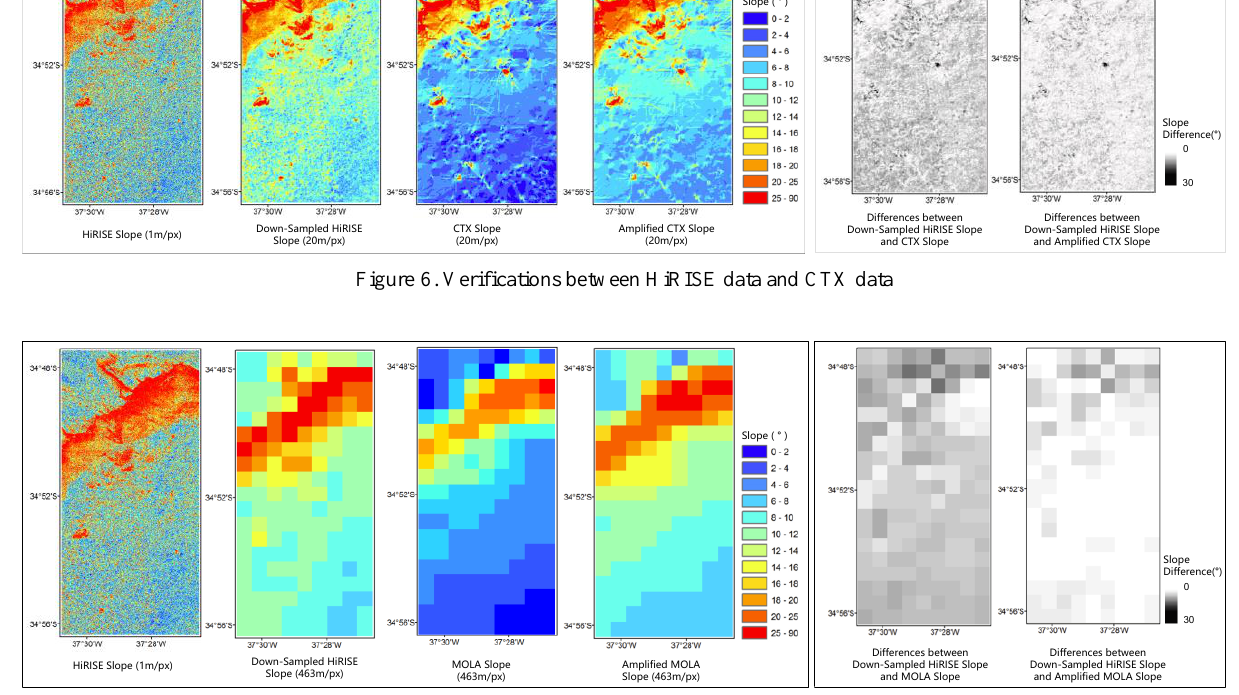
Figure 7. Verifications between HiRISE data and MOLA